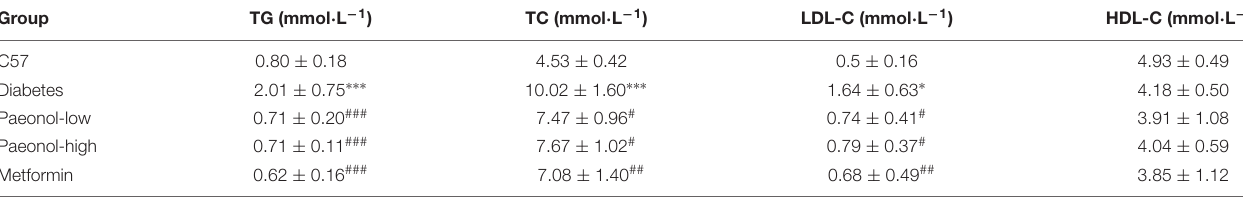
TABLE 1 | The serum lipid levels of diabetic mice after PA treatment ( n = 6–8).